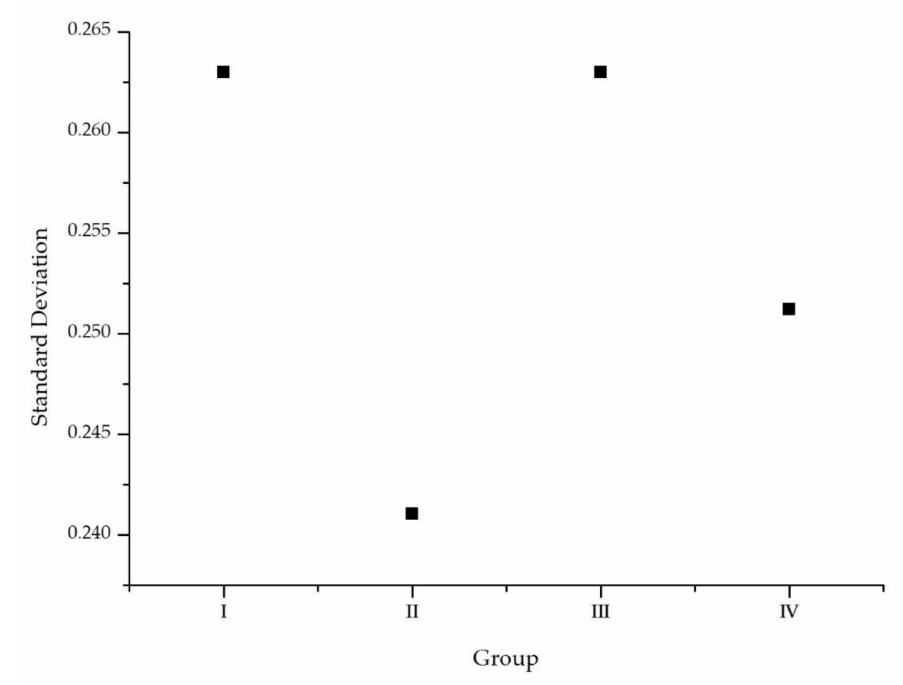
Figure 8. The standard deviation of the cells’ Jsc of four